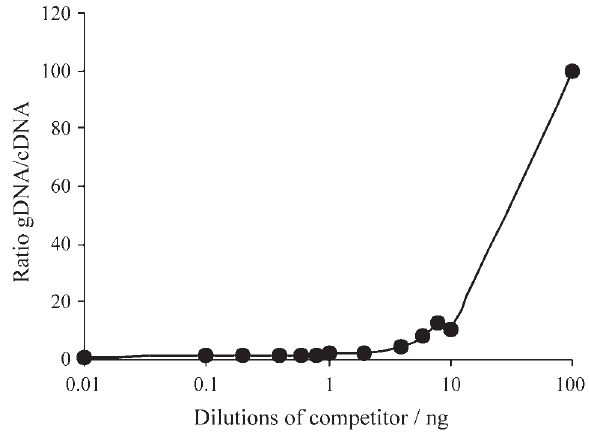
Figure 8 - Plotted gDNA/cDNA ratio after amplification, versus competi- tor dilutions added to mixture (100 ng, 10 ng, 8 ng, 6 ng, 4 ng, 2 ng, 1 ng, 0.8 ng, 0.6 ng, 0.4 ng, 0.2 ng, 0.1 ng, and 0.01 ng).